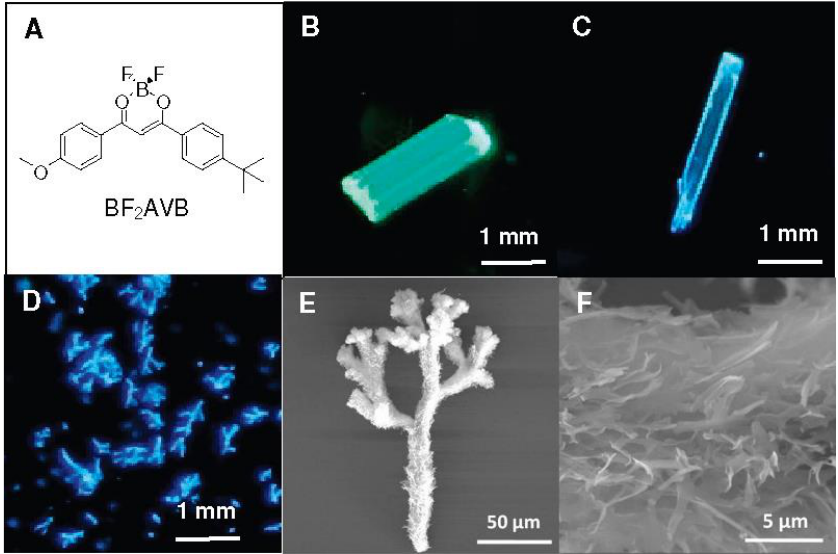
Figure 13. ( A ) Chemical structure of BF 2 AVB. ( B – D ) Photos showing ( B ) green and ( C ) cyan crystals, and ( D ) the blue coral-like solid under UV excitation ( λ ex) 365 nm). ( E ) SEM image of the dendritic coral-like structure. ( F ) Magnified view of the porous surface.